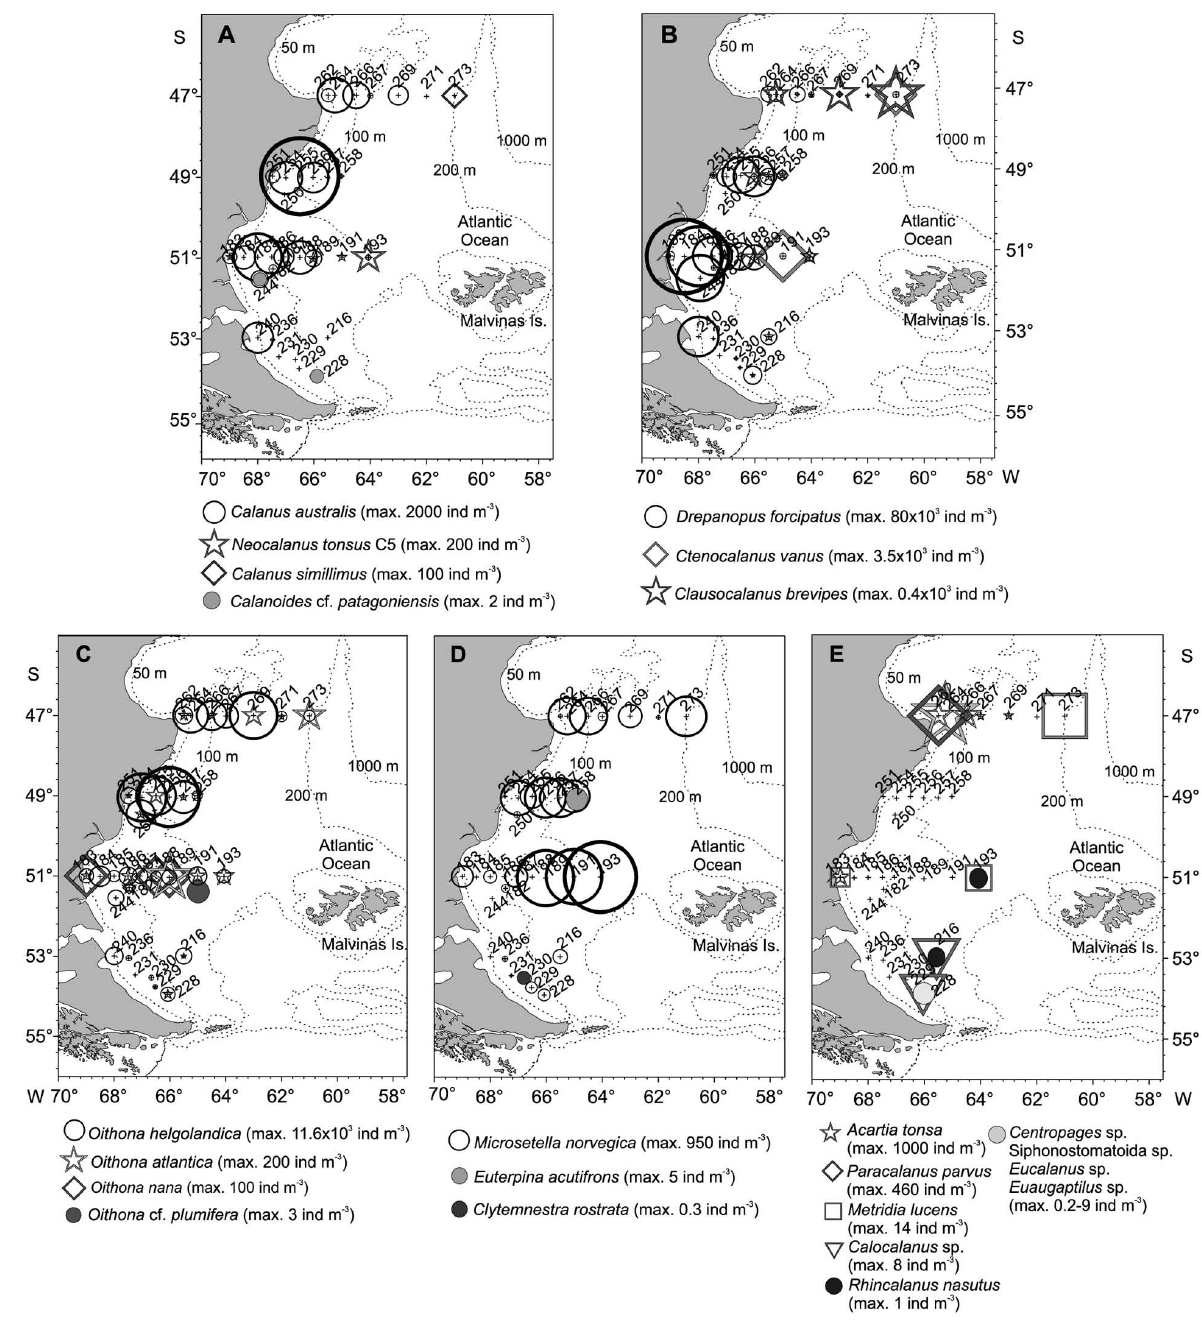
Fig. 3. – Spatial distribution and abundance of (A) large-sized calanid copepods (B) medium-sized clausocalanid copepods, (C) small-sized cyclopoid copepods, (D) small-sized harpacticoid copepods and (E) other less abundant and less frequent copepod